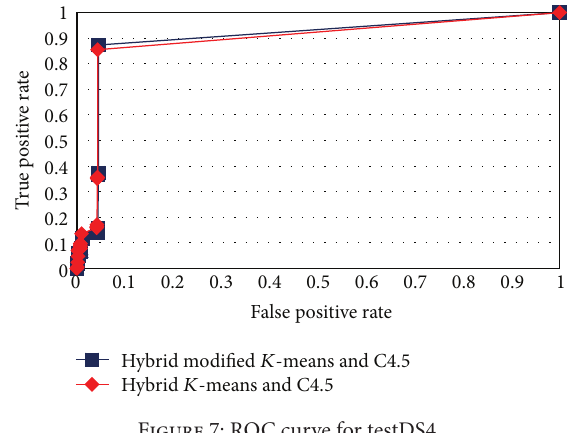
Figure 4: ROC curve for testDS1.